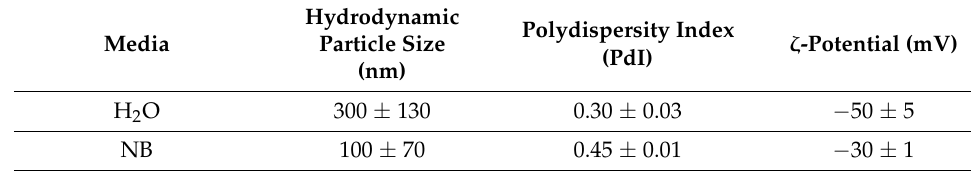
Table 1. Colloidal characterization of AgBDC suspensions in water or NB at 37 ◦ C.